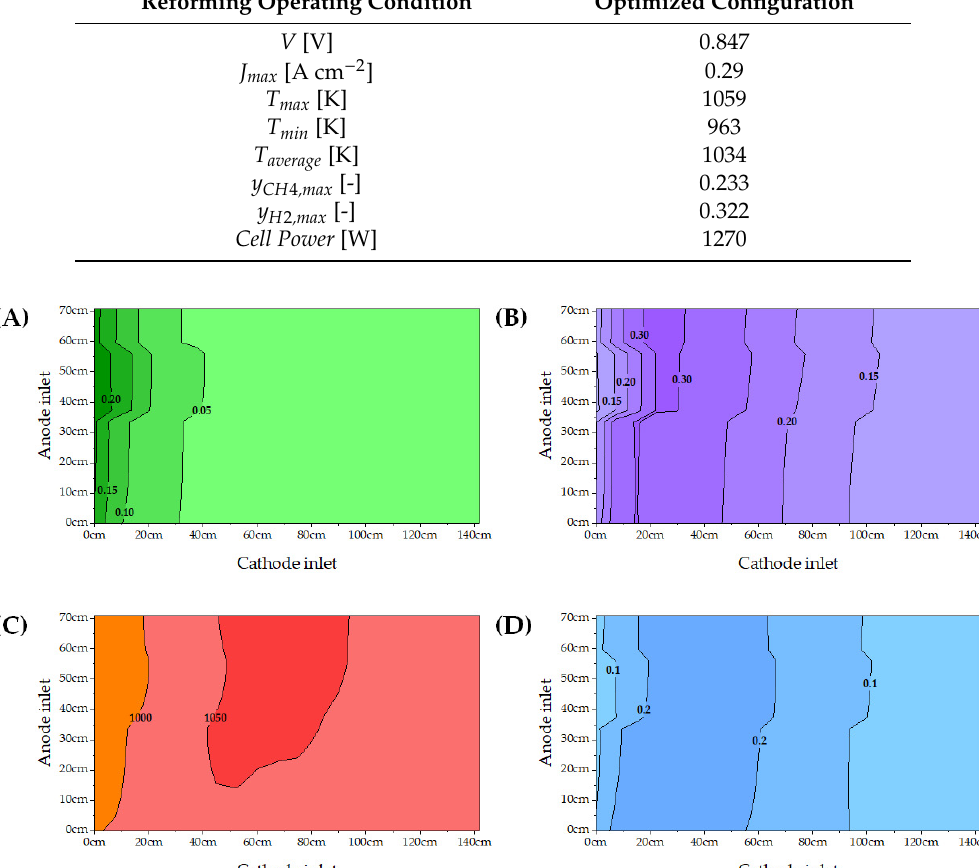
Figure 5. Results of the DIR-SOFC simulation using the SR kinetics approach correcting the catalyst actual surface area to obtain cell performance optimization; local maps of molar fraction of CH 4 ( A ) and H 2 ( B ), temperature of the solid structure in K ( C ), and current density in A cm − 2 ( D ).